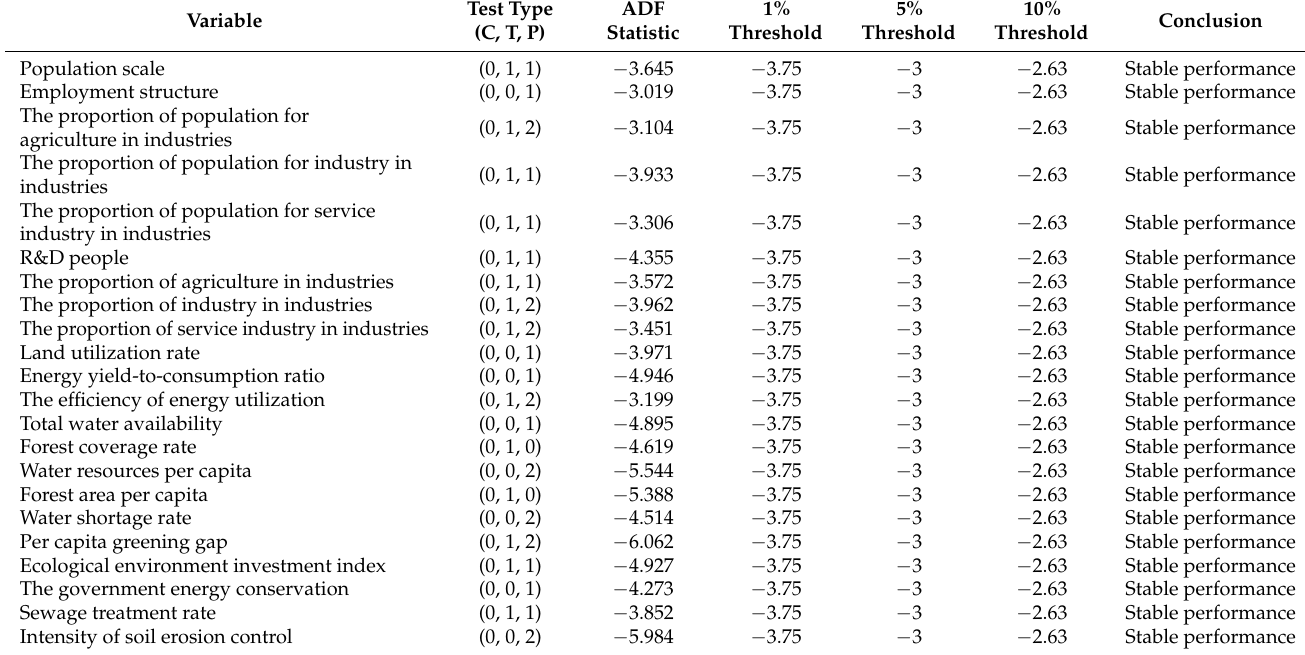
Table 2. Consistency